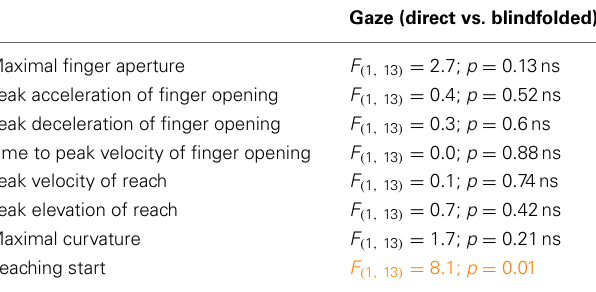
Table 2 | Results of statistical analyses performed on kinematic parameters in Experiment